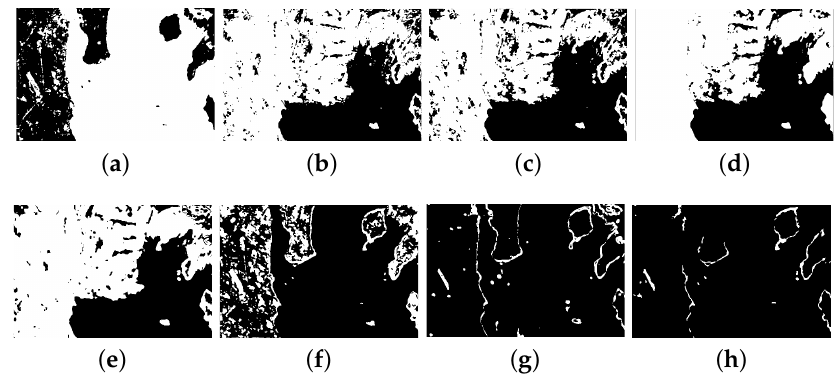
Figure 24. Change detection results obtained by different methods in the Campbell River data set: ( a ) subtraction, ( b ) log-ratio, ( c ) wavelet fusion, ( d ) DNN, ( e ) SSCNN, ( f ) SCCN, ( g ) DADNN, and ( h ) ground